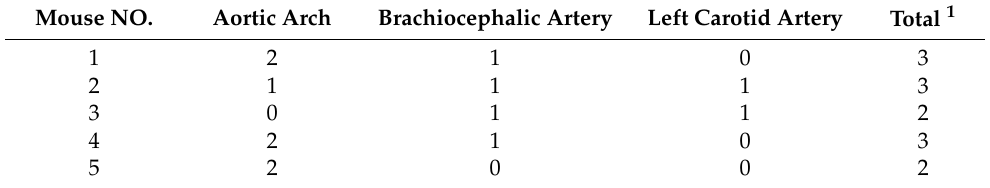
Table 1. Number and anatomical regions of the radio-dense spots observed in the Warfarin group. Mouse NO. Aortic Arch Brachiocephalic Artery Left Carotid Artery